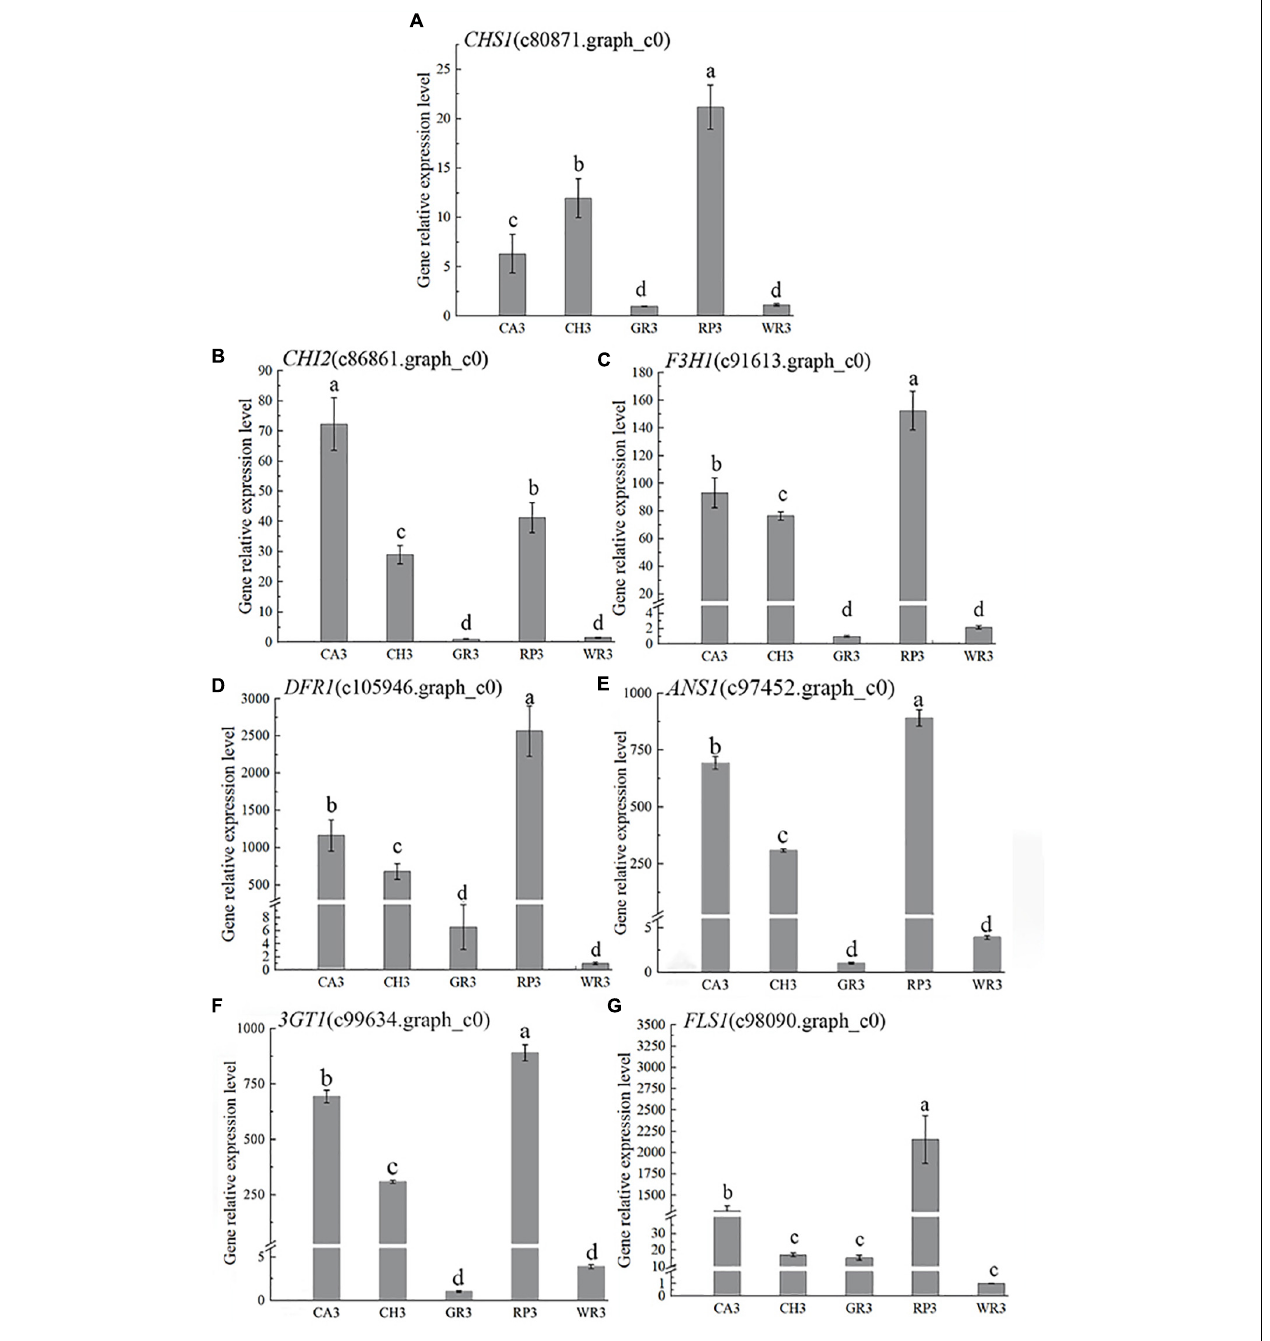
FIGURE 3 | The expression characteristics of seven structural genes of Freesia hybrida . (A) CHS1 , (B) CHI2 , (C) F3H1 , (D) DFR1 , (E) ANS1 , (F) 3GT1 , and (G) FLS1 . GR3 was chosen as calibrator sample of CHS1 , CHI2 , F3H1 , and 3GT1 ; WR3 was chosen as calibrator sample of DFR1 , ANS1 , and FLS1 . Lowercase letters stand for the significance of difference at 0.05